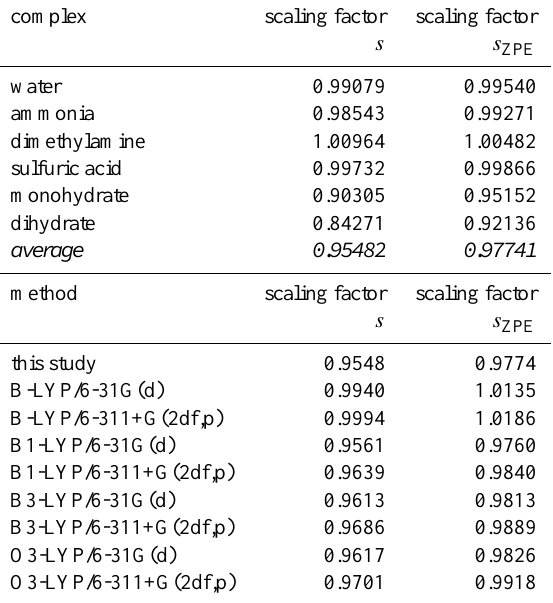
Table 1. The individual scaling factors used in this study; s for the entropies and thermal parts of enthalpies, and s ZPE for the zero- point vibrational energy contribution of enthalpy. Here “monohy- drate” refers to the monohydrate of sulfuric acid and “dihydrate” to the dihydrate of sulfuric acid. The lower part of the table shows a comparison between the averages of the individual scaling factors used in this study and other scaling factors for some common ex- change and correlation functionals (Merrick et al., 2007). However, the values are not directly comparable as they are obtained using different